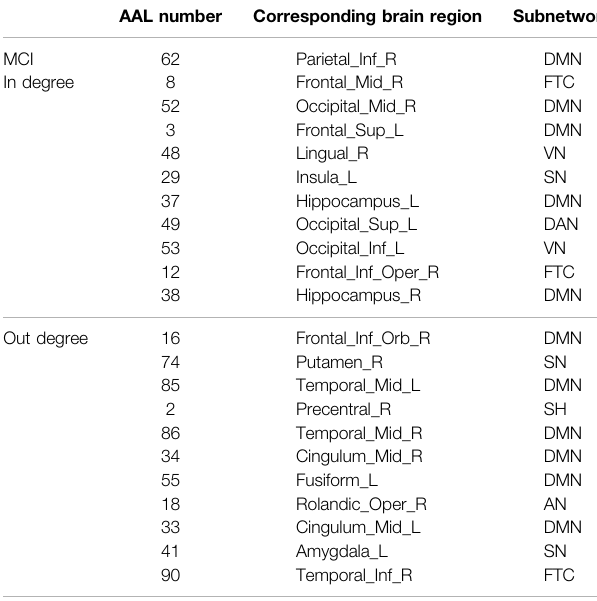
TABLE 4 | Hubs of the MCI group based on the GCM method.